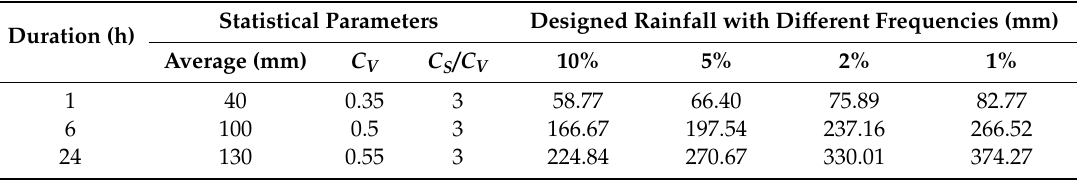
Table 7. Designed rainfall with di ff erent frequencies.